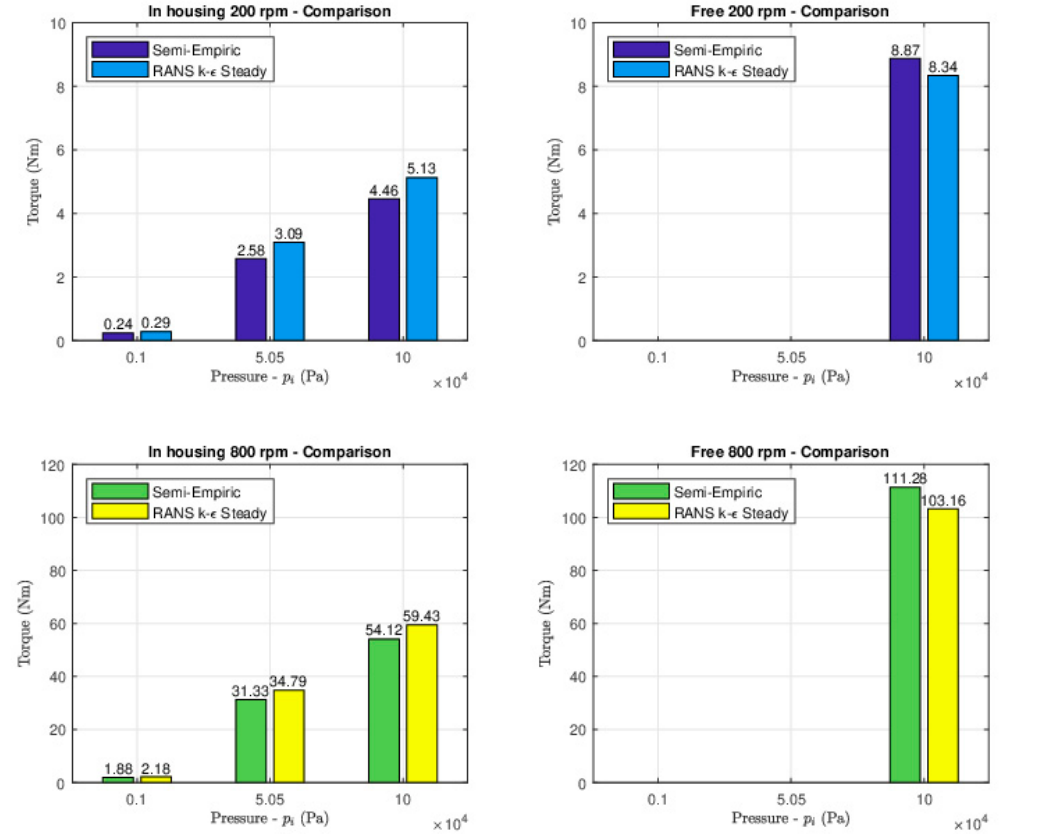
Figure 9. Total fluid friction torque for the In housing configuration: Semi-empiric vs.